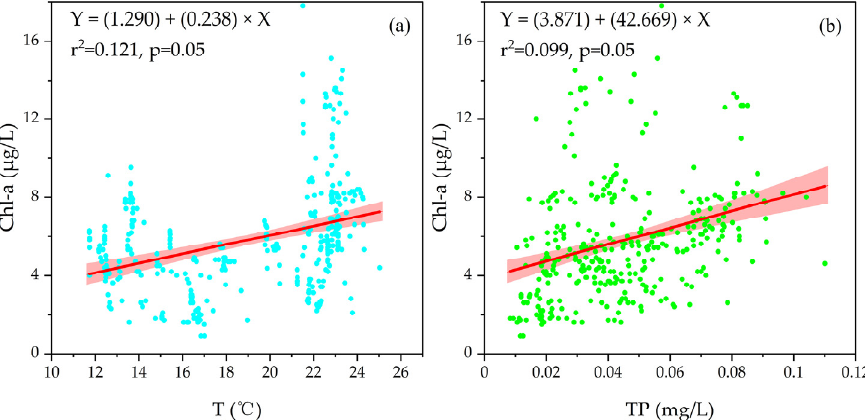
Figure 9. Linear regression relationship of T to Chl ‐ a. ( a ) and TP to Chl ‐ a. ( b )